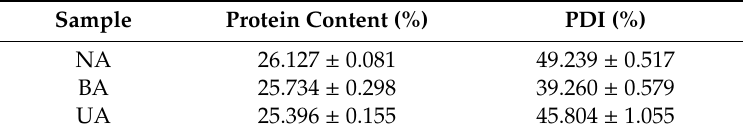
Table 4. Protein content (%) and Protein Dispersibility Index in for NA, BA and